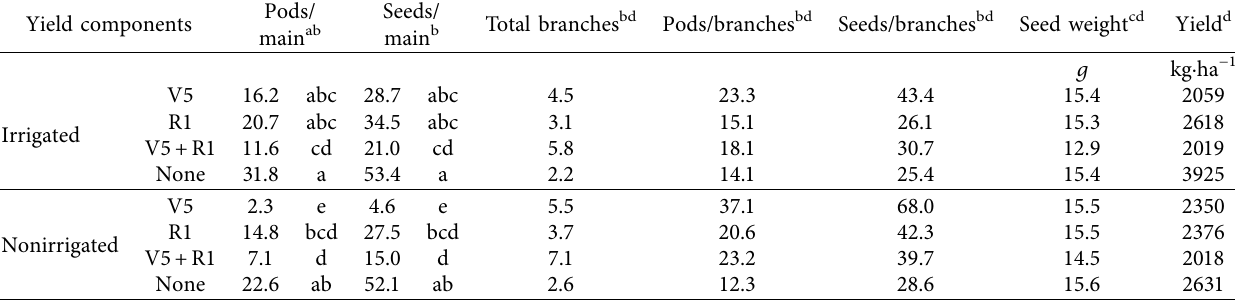
Table 3: Effects of irrigation regime and application timing on yield components and grain yield collected for evaluation in the irrigation experiments conducted in Fayetteville and Colt, AR, in